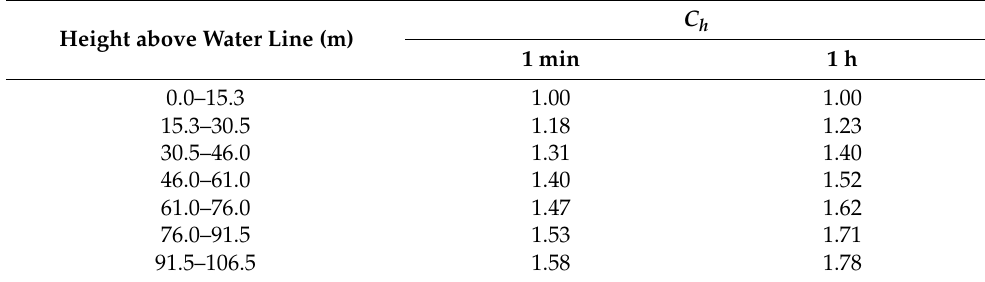
Table 5. Height coefficient C h for